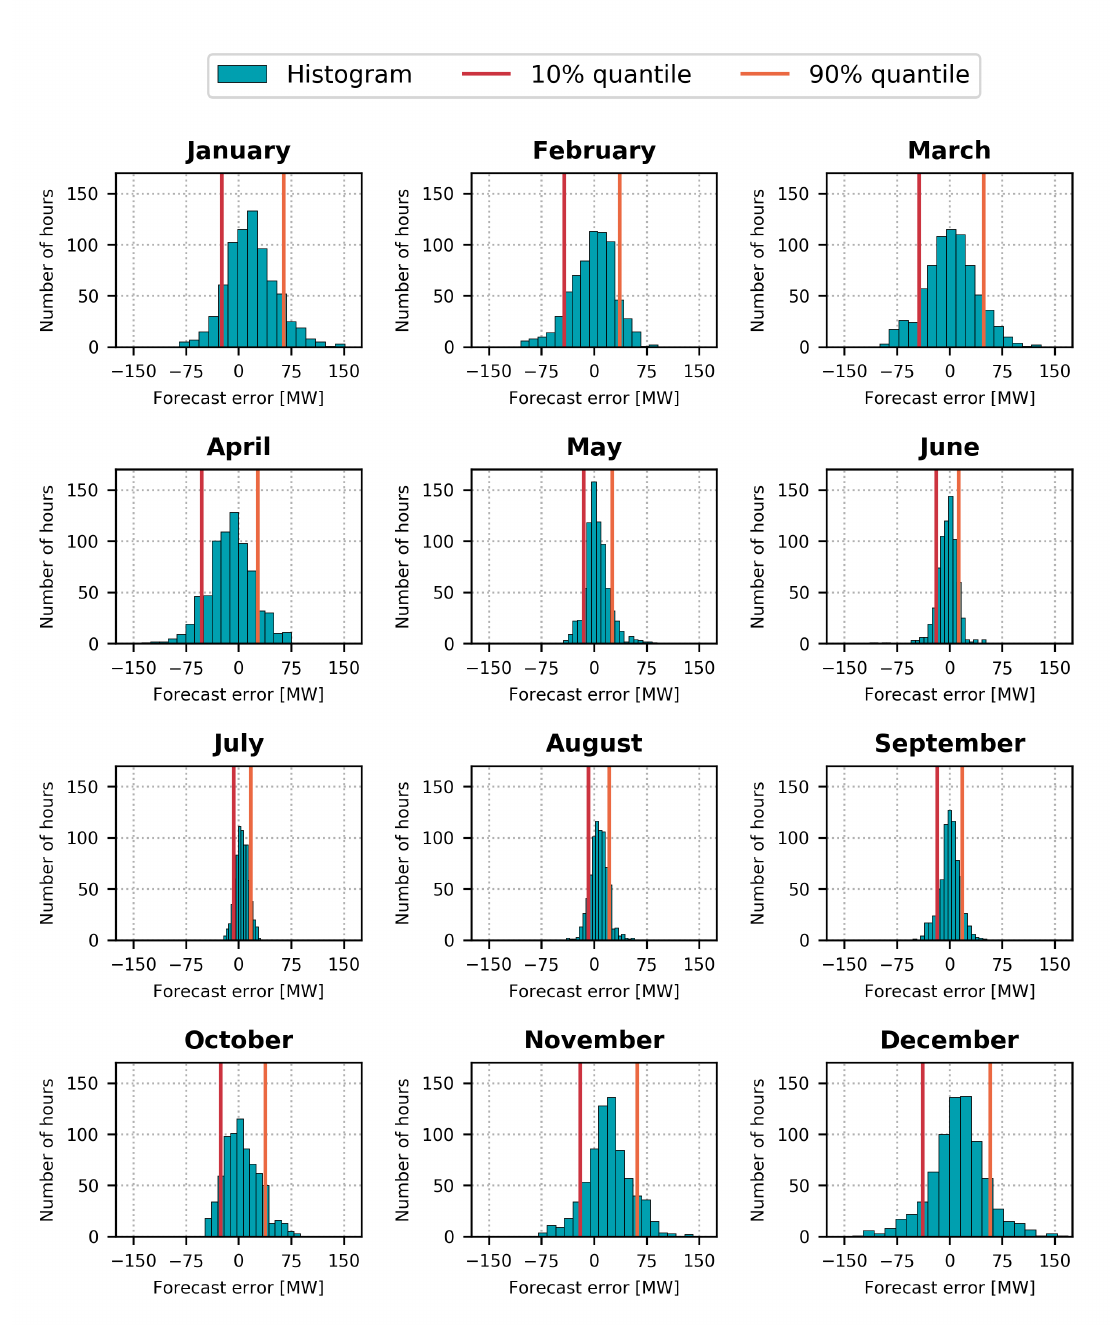
Figure 6. Histograms for the forecast error of the SVR model on the year 2016 using real weather forecasts, calendar, and holiday data. The distribution of the forecast error is depicted for each month in the year along with the 10% and 90% quantiles. The number of bins was chosen using Scott’s rule [25] within each month. A positive error indicates that the forecast was too high, a negative error that it was too